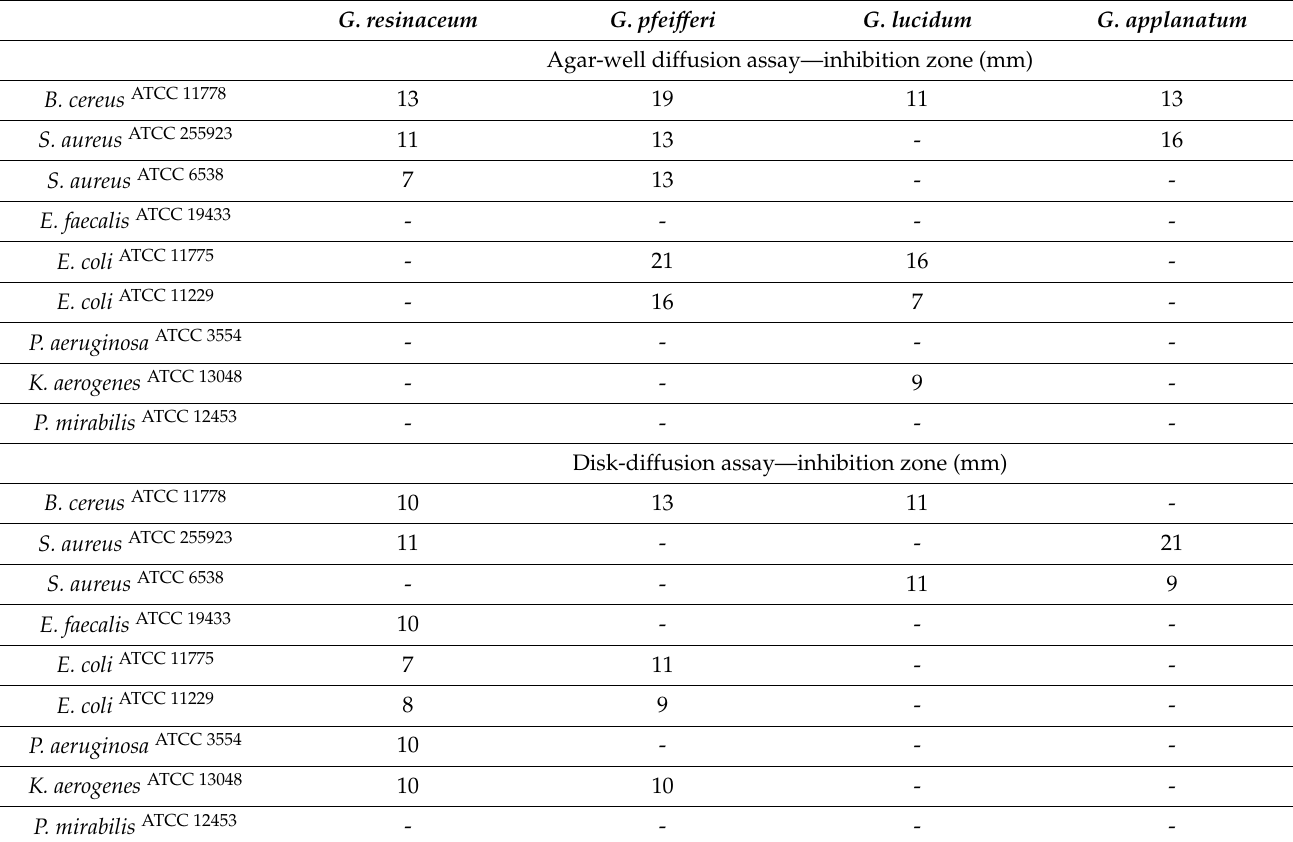
Table 2. Antibacterial activity of H 2 O Ganoderma extracts using three different antibacterial assays. G.